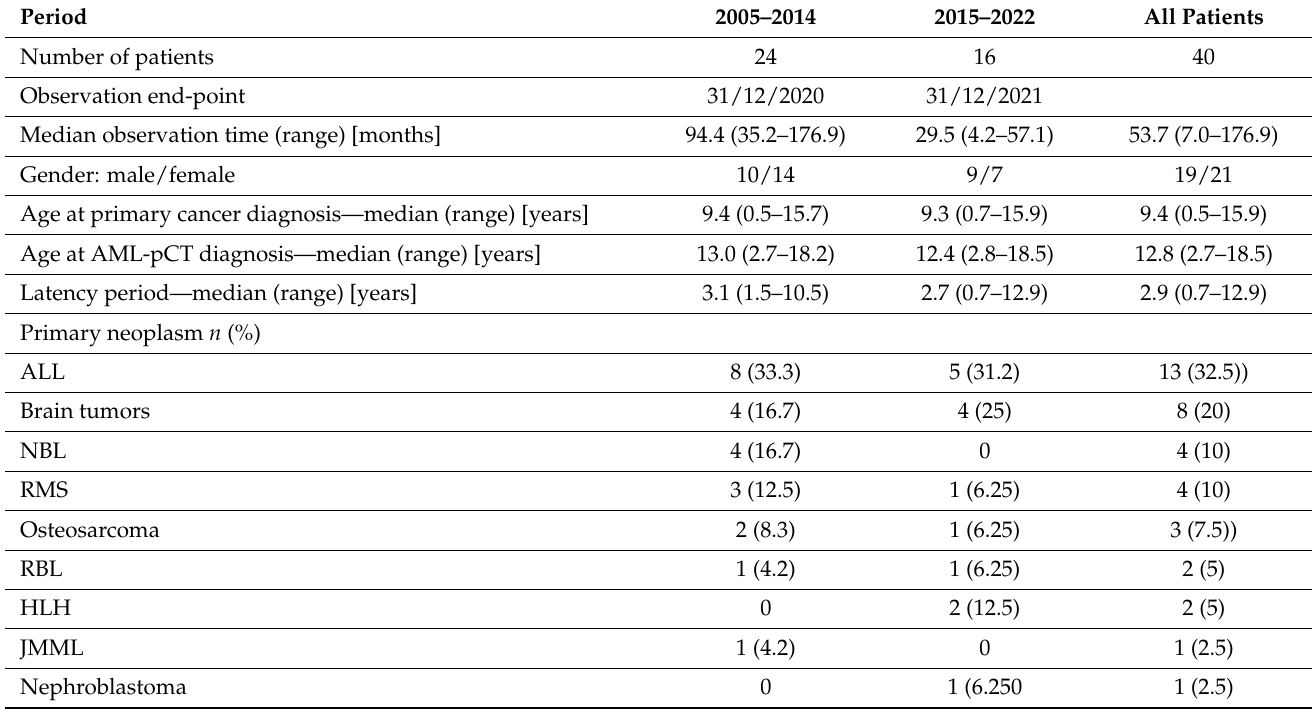
Table 1. The patients’